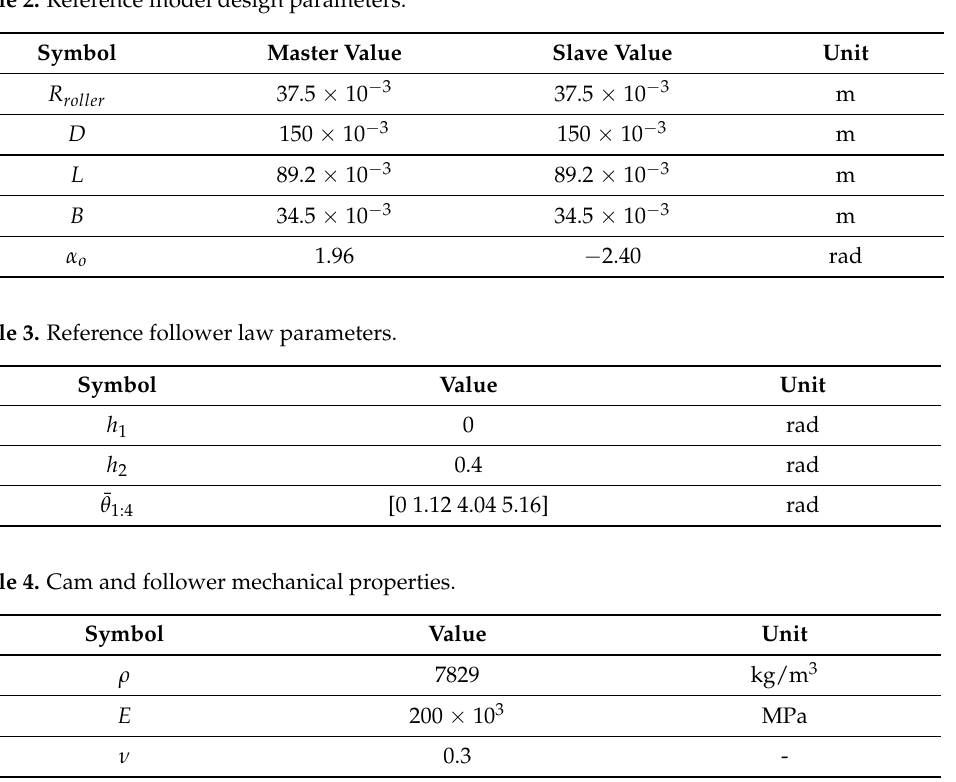
Table 2. Reference model design parameters.